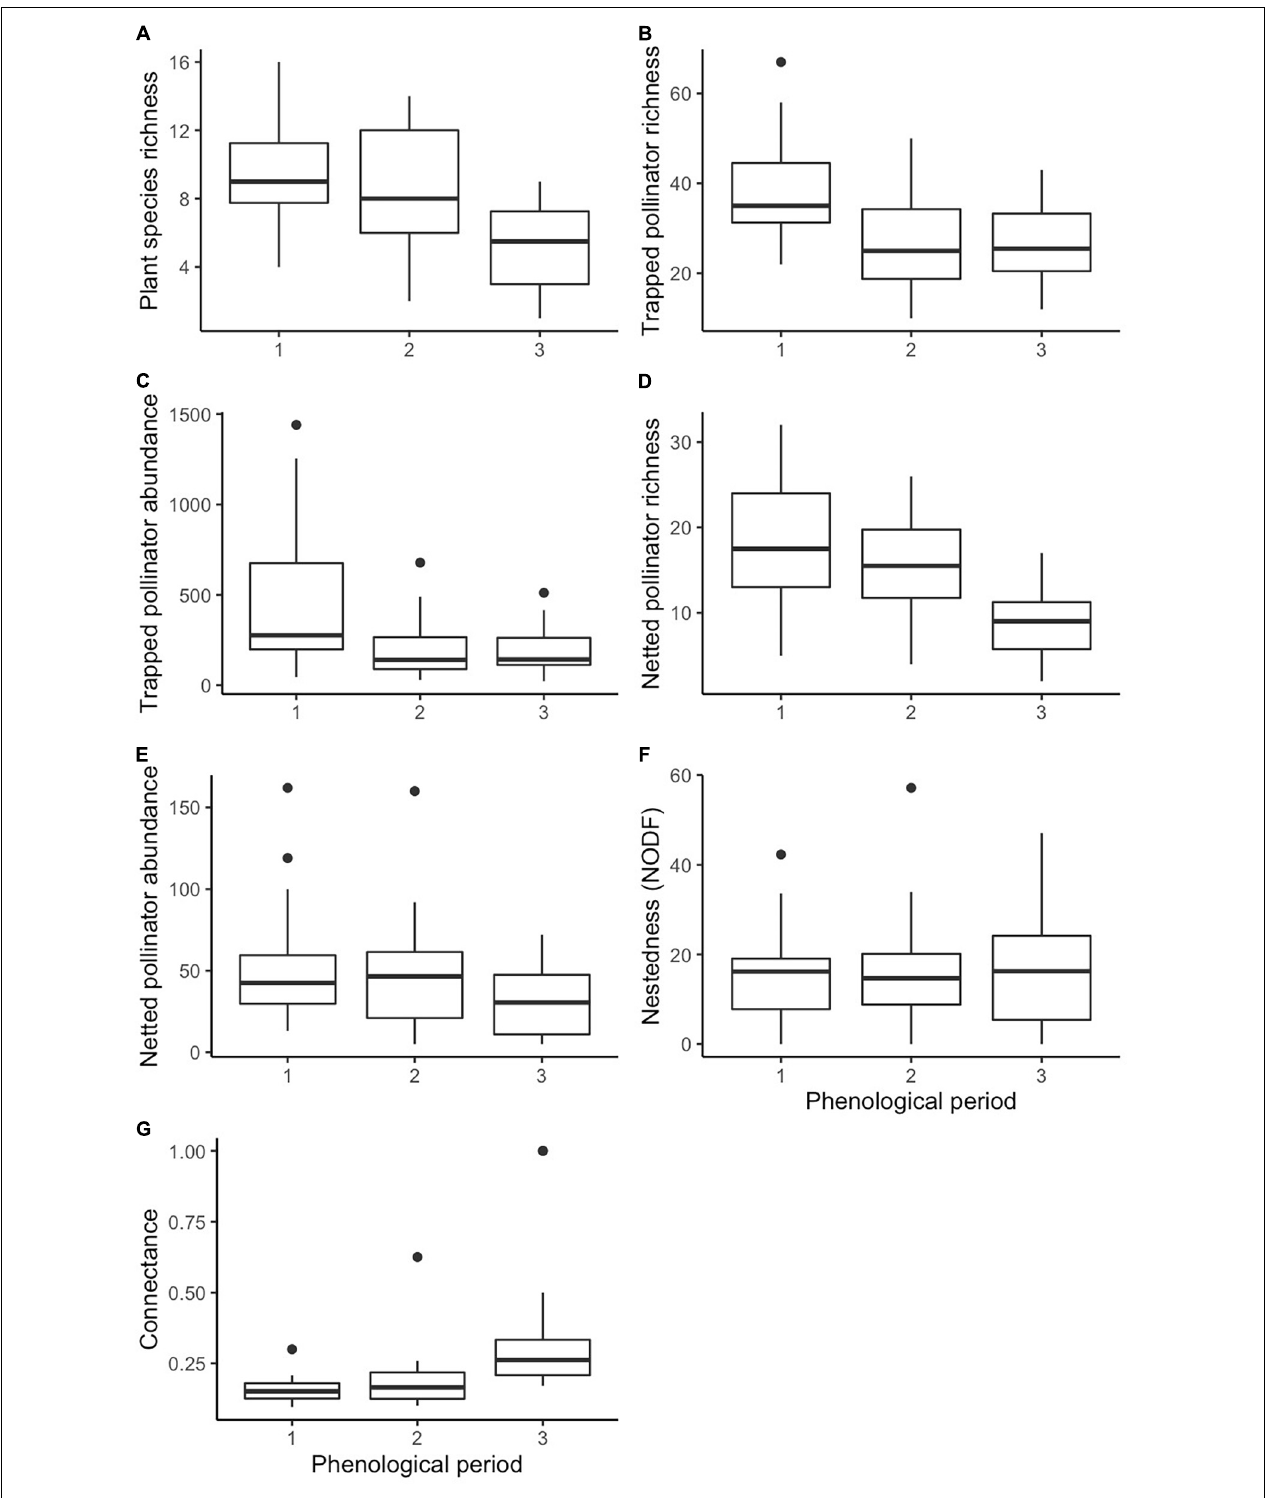
FIGURE 1 | Boxplots displaying phenological period as a significant predictor of plant species richness (A) , trapped pollinator richness (B) , trapped pollinator abundance (C) , netted pollinator richness (D) , netted pollinator abundance (E) , network NODF (F) , and network connectance (G) .